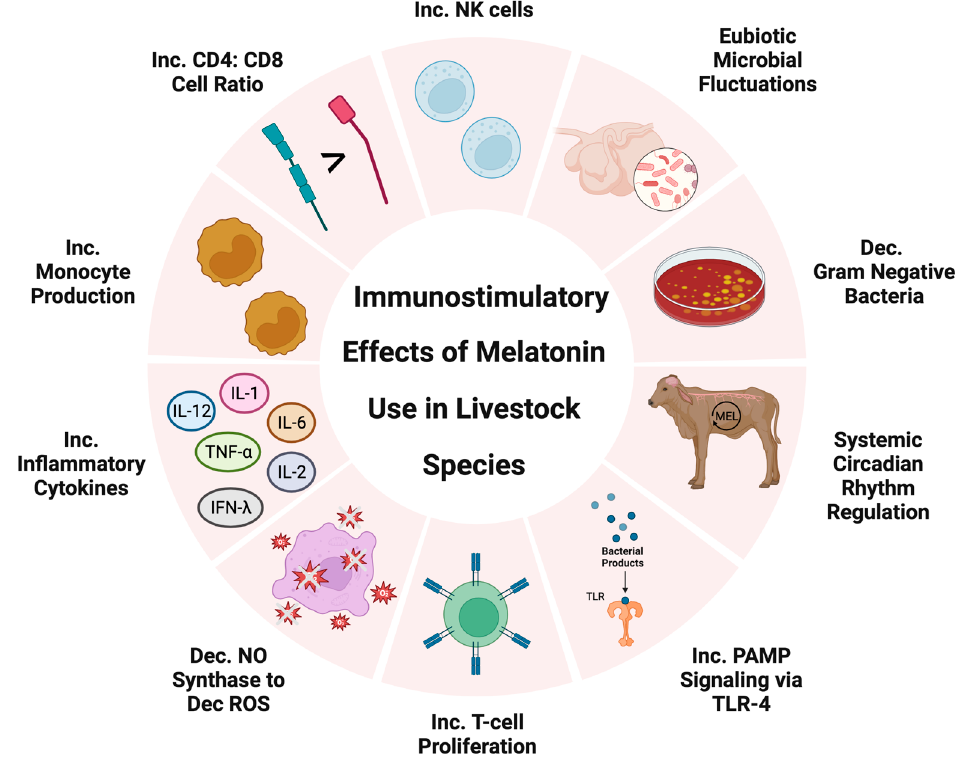
Figure 1. Figure depicting how peripheral concentrations of melatonin impact the immune responses throughout the body via systemic circadian rhythm regulation. Increased concentrations of melatonin altered eubitoic microbial populations, increased immunocompetent cells (natural killer cells (NK), monocytes, and T cells), and cytokine production (IL-1, IL-2, IL-6, IL12, TNF-alpha, and IFN-gamma), decreased nitric oxide (NO) synthase production, resulting in decreased reactive oxygen species (ROS), and increased pathogen-associated molecular patterns (PAMP) signaling via toll-like receptor 4 (TLR-4). The figure was created with BioRender.com (accessed on 29 January